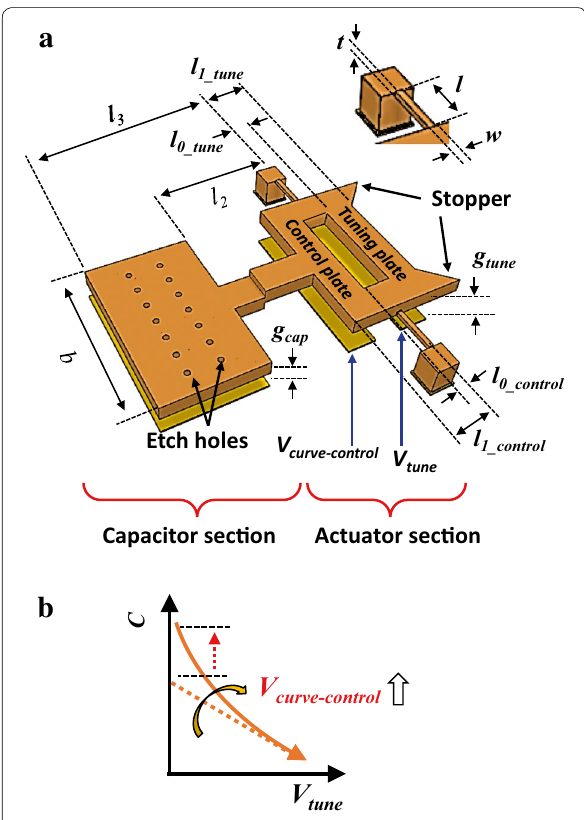
Fig. 2 Proposed MEMS varactor employing a levering actuator. a Perspective view, b tunable C–V tune characteristic with respect to V